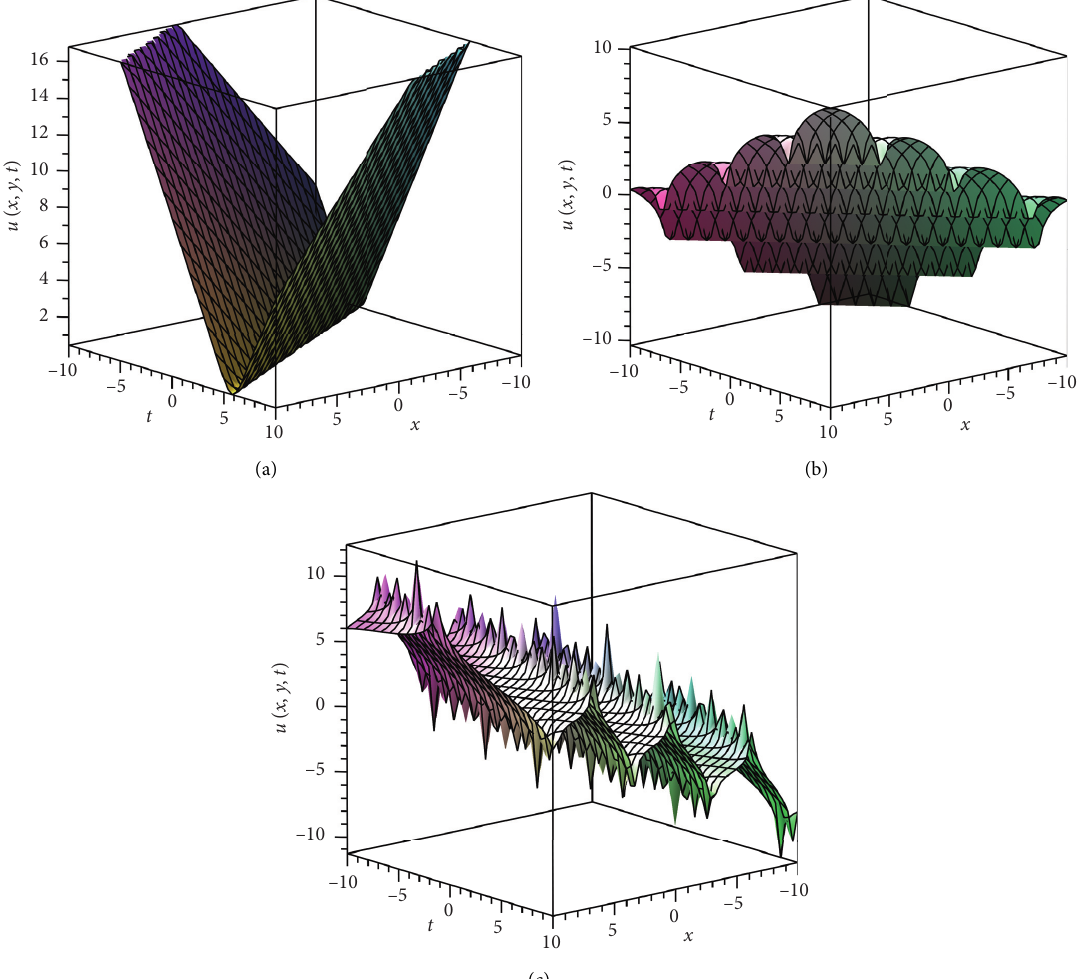
Figure 2: Plots of the solutions of (2) obtained using the Jacobi elliptic equation method and setting y � 0: (a) solution (51) with M � 1, (b) solution (64) with M � 0, and (c) solution (116) with M �